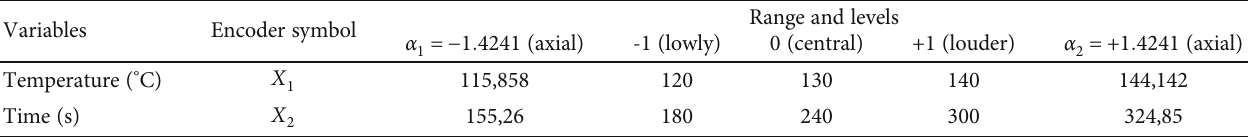
Table 1: Central composite rotational design matrix (DCC-R) with axial points and coded central points: vacuum frying. Variables